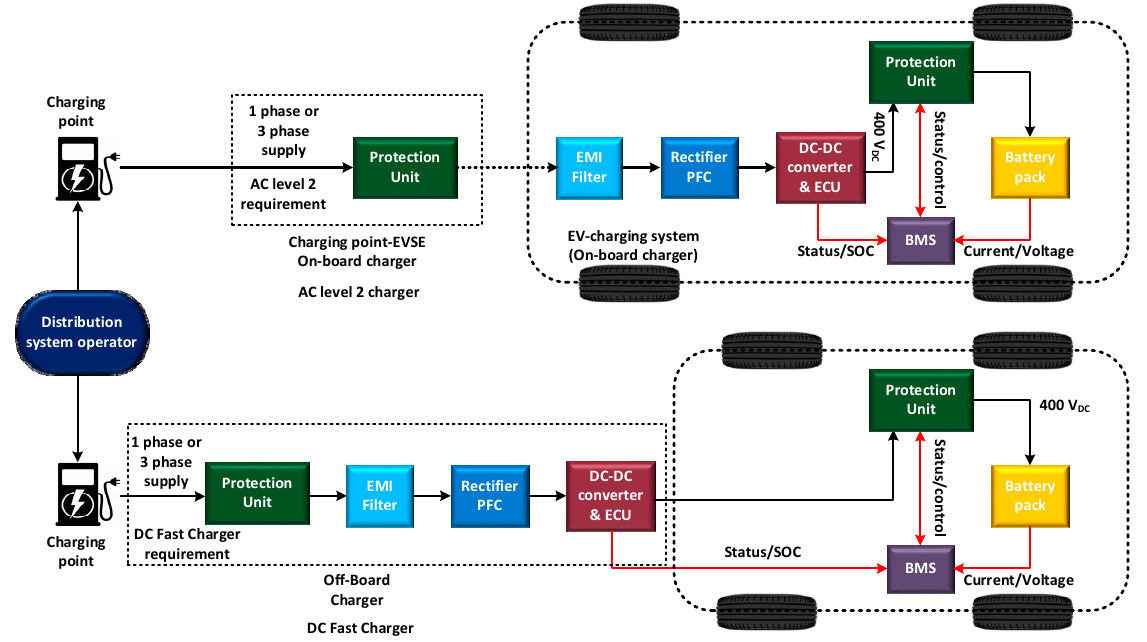
Figure 16. The on-board and off-board conductive charging infrastructures.